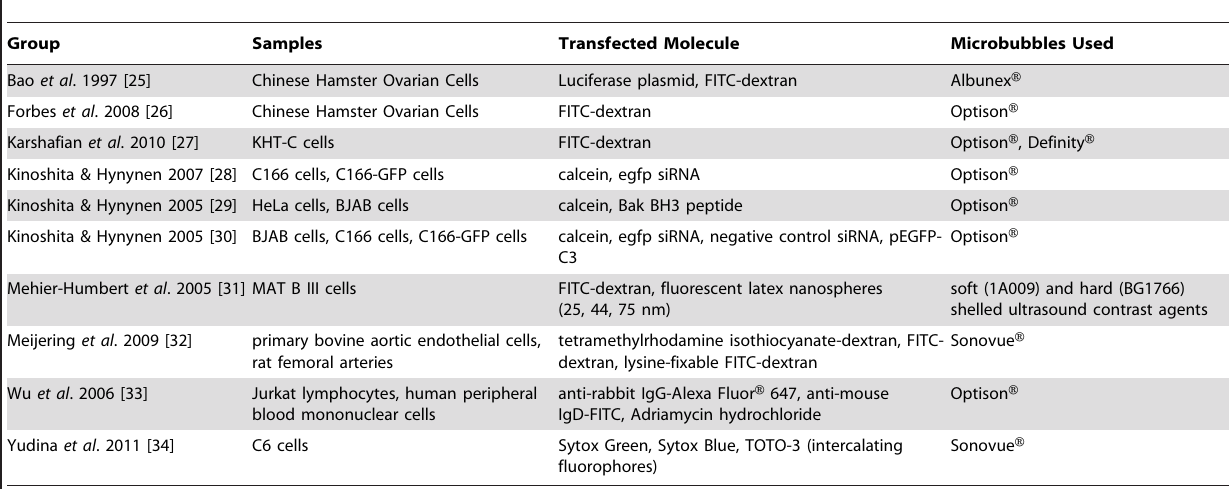
Table 1. Examples of experiments using sonoporation to transfer large molecules across the cell membrane.